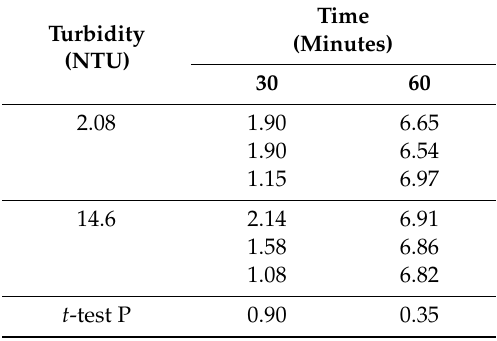
Table 5. E ff ect of turbidity on log removal values ( LRV ) at 60 ◦ C for three replicate experiments, native E. coli.